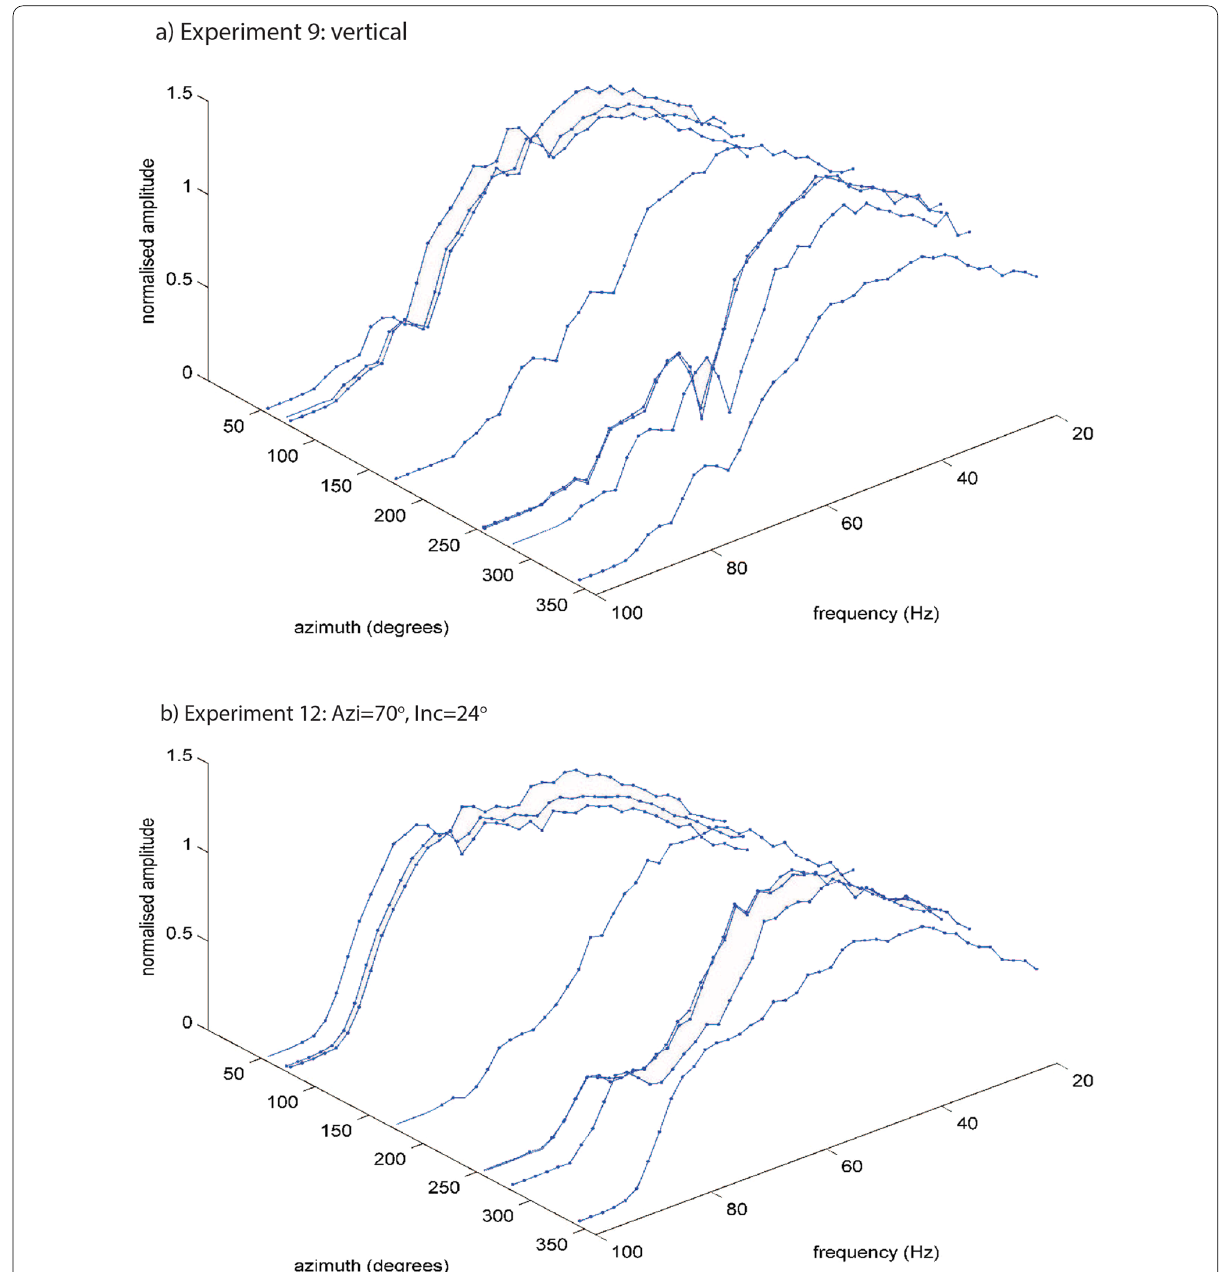
Fig. 6 Azimuthally grouped spectra for a Experiment 9 and b Experiment